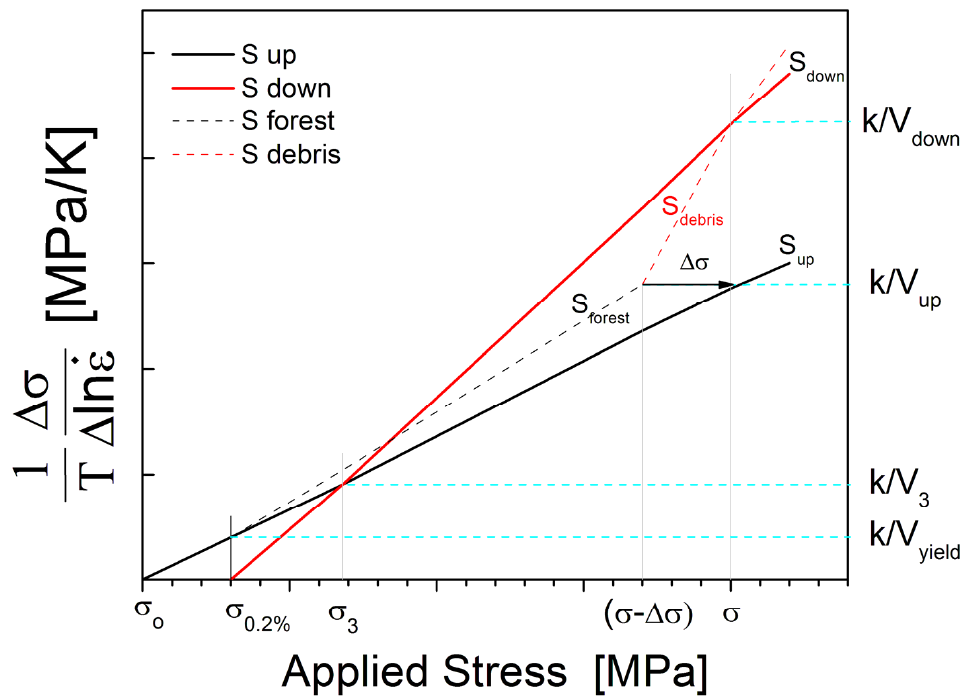
Figure 3. Schematic Haasen plot showing the contributions from various obstacle types (forest, debris) to the flow stress detectable by instantaneous up- or down-changes in the strain rate. Note that the extension of k/ ν 3 intersects S for resulting in a smaller ∆ σ that is attributed to the contribution of attractive intersection, estimated to be less than 10% of repulsive one at 78 K and negligible at higher temperature.